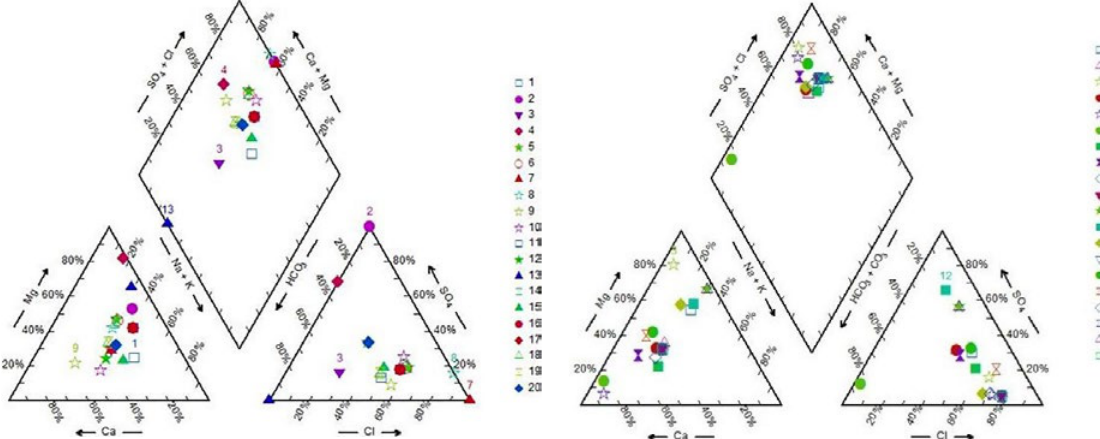
Fig.3a: Piper diagram for Omani brands Fig. 3b: Piper diagram for UAE brands